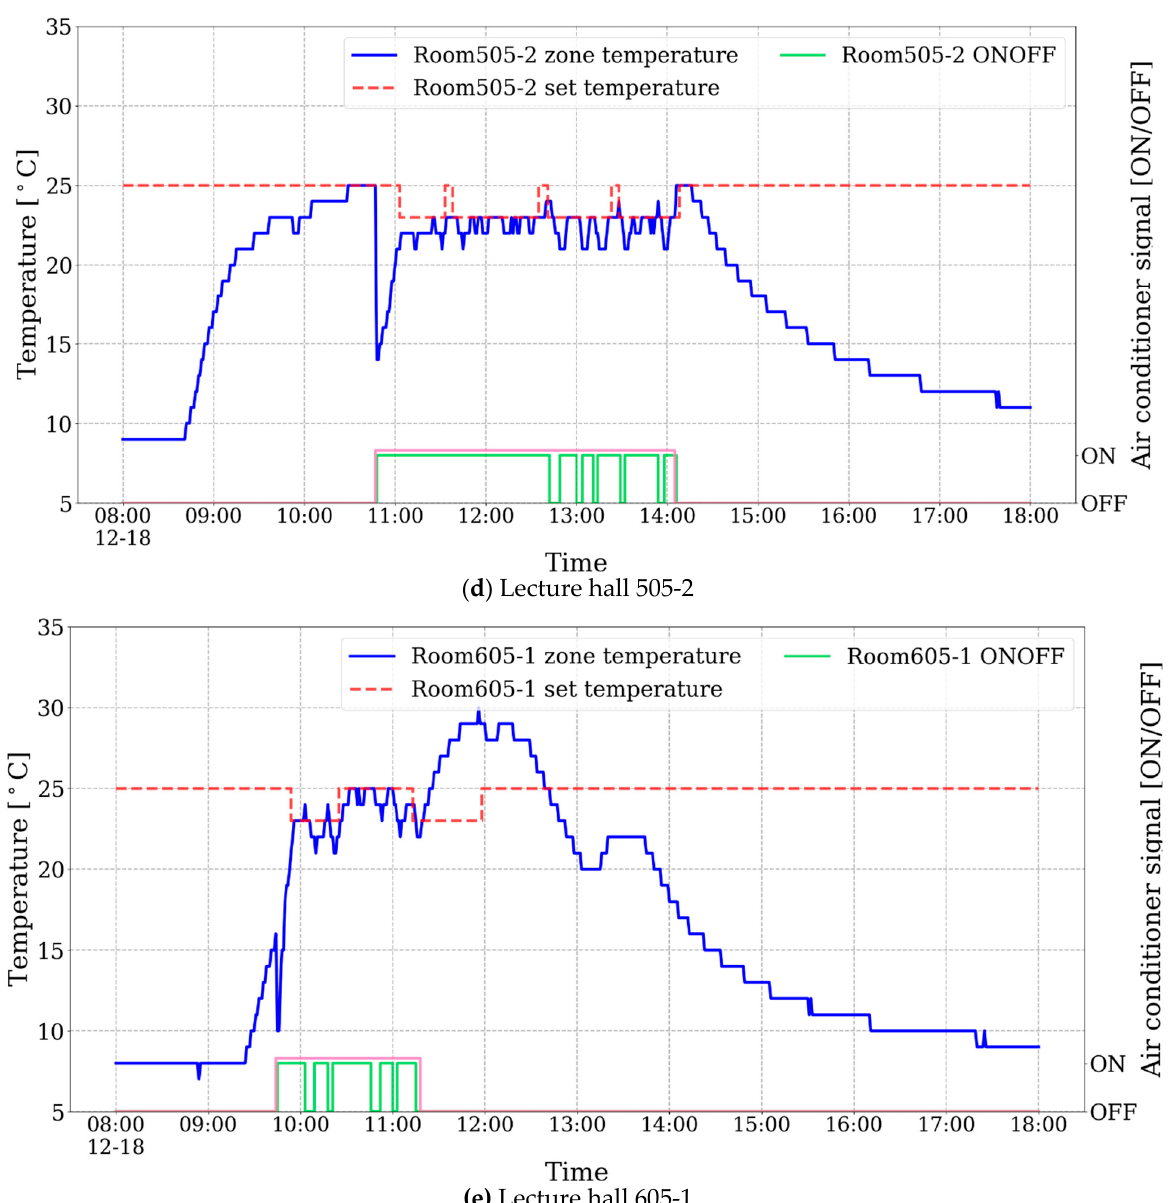
Figure 21. Reduction ratio 15% result of the field test with the zone temperature, set temperature, and air conditioners operating state applying the building control algorithm. ( a ) Lecture hall 201-1; ( b ) Lecture hall 304; ( c ) Lecture hall 402-2; ( d ) Lecture hall 505-2; ( e ) Lecture hall